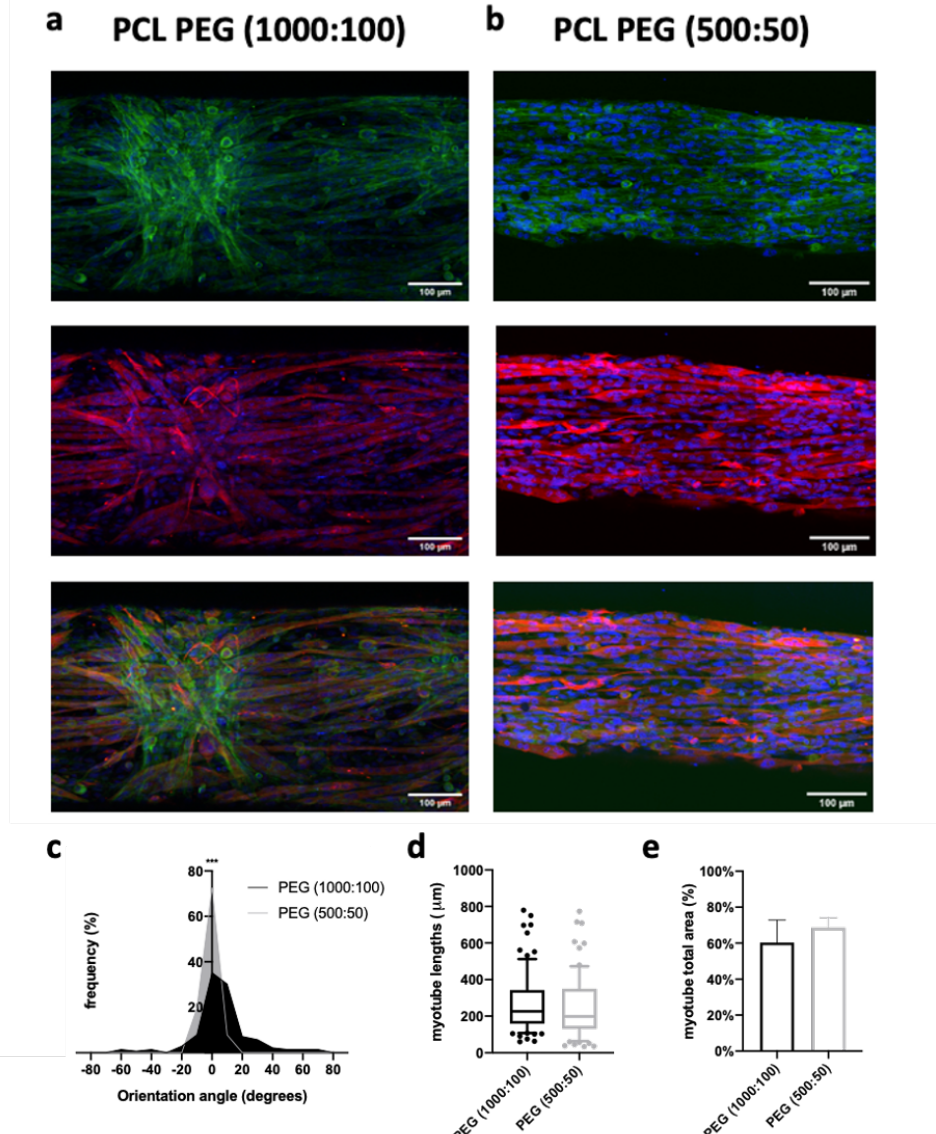
Figure 7. Myotube morphology on the scaffolds. Confocal images of C2C12 cells after 7 days of culture on scaffolds coated or not with gold nanoparticles with a space of ( a ) 1000 µm or ( b ) 500 µm between the hydrogel lines. Nuclei in blue fluorescence (Hoechst 33258), F-actin in green fluorescence and myotubes by anti-MHC antibodies in red fluorescence. Scale bar: 100 µm. Quantification of the ( c ) orientation (significance analyzed by Mann–Whitney nonparametric two-tailed test), ( d ) length and ( e ) total area occupied by the myotubes as a function of the space patterning ( n = 50 myotubes). There was no statistical difference between the conditions of the length and area of the myotubes. p < 0.001. *** indicates significant